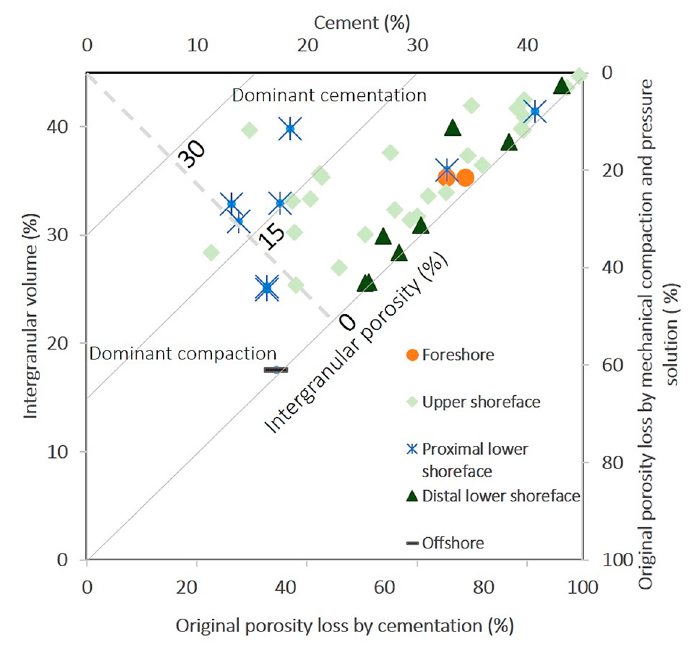
Figure 17. Intergranular volume (%) versus cement (%) diagram after the method developed by Houseknecht [45] showing the role of cementation and compaction in initial porosity-loss with the distal lower shoreface and offshore facies associations having the highest initial porosity-loss.